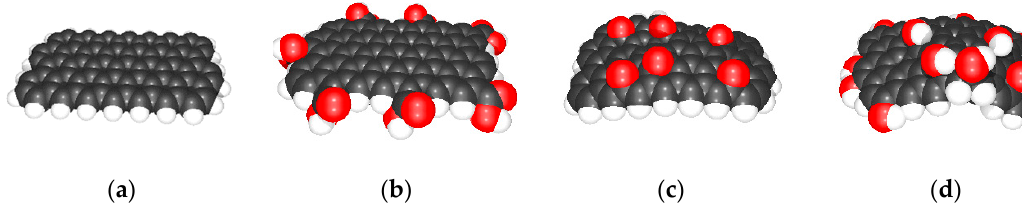
Figure 2. Results of ab-initio calculations to model the geometries of graphene-like and GO-like molecules: ( a ) graphene-like structure consisting of four rows of heptacene; ( b ) oxidized graphene carrying sterically demanding carboxylic groups on the edge; ( c ) oxidative attack on the carbon atoms in the molecular plane formed oxiran groups instable in acidic media; and ( d ) GO-like molecule decorated with hydroxyl groups on the edge and in the molecular plane.